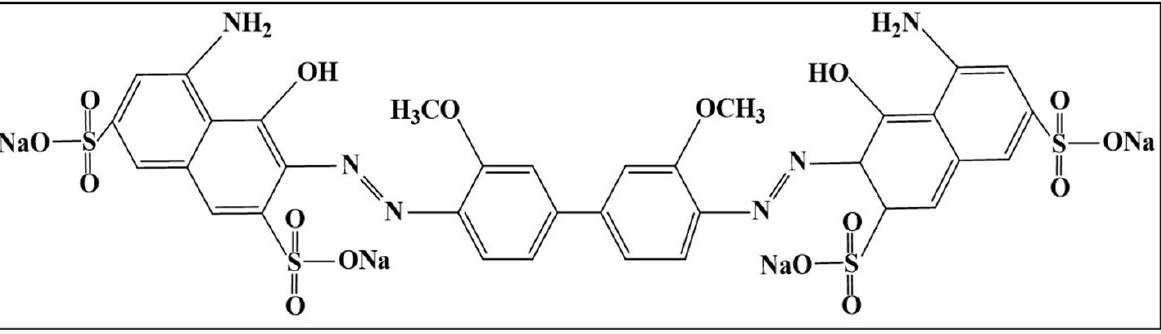
Figure 1. Chemical structure of DB15.